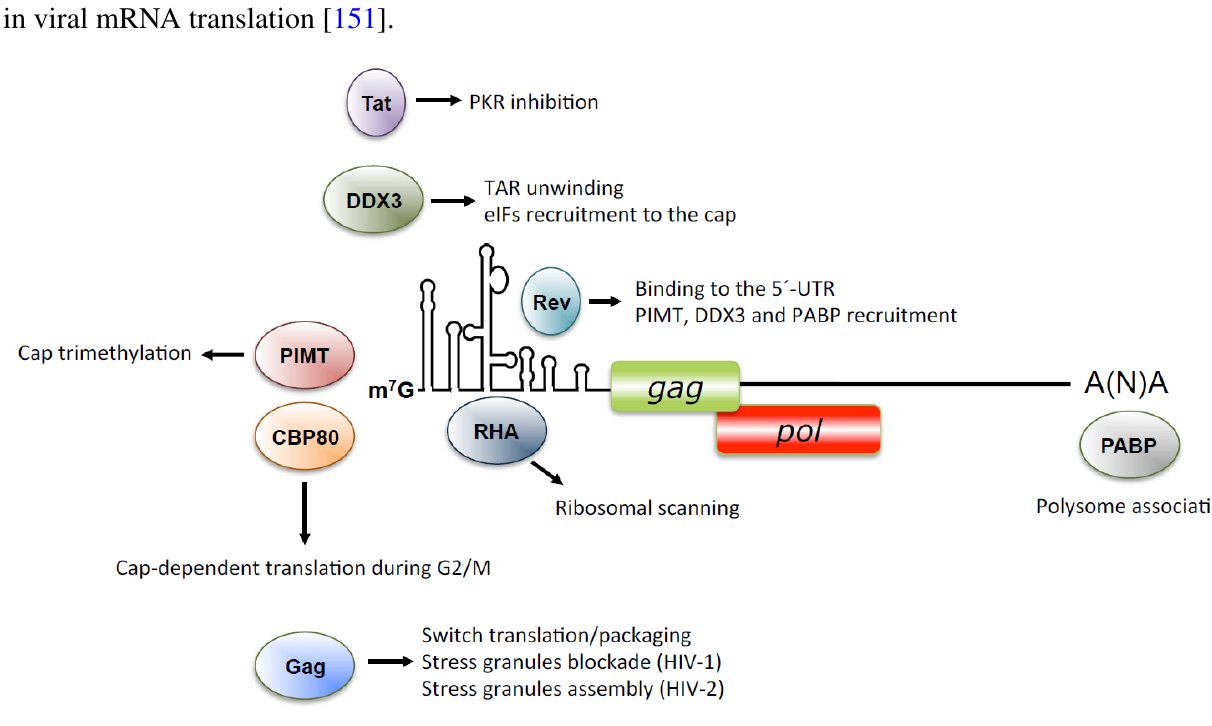
Figure 4. Translational control by host and viral proteins. Schematic representation of the panel of viral (Rev, Tat, Gag) and cellular (DDX3, PIMT, CBP80, RHA, and PABP) proteins required to assist translation initiation from the HIV-1 and HIV-2 unspliced mRNA.